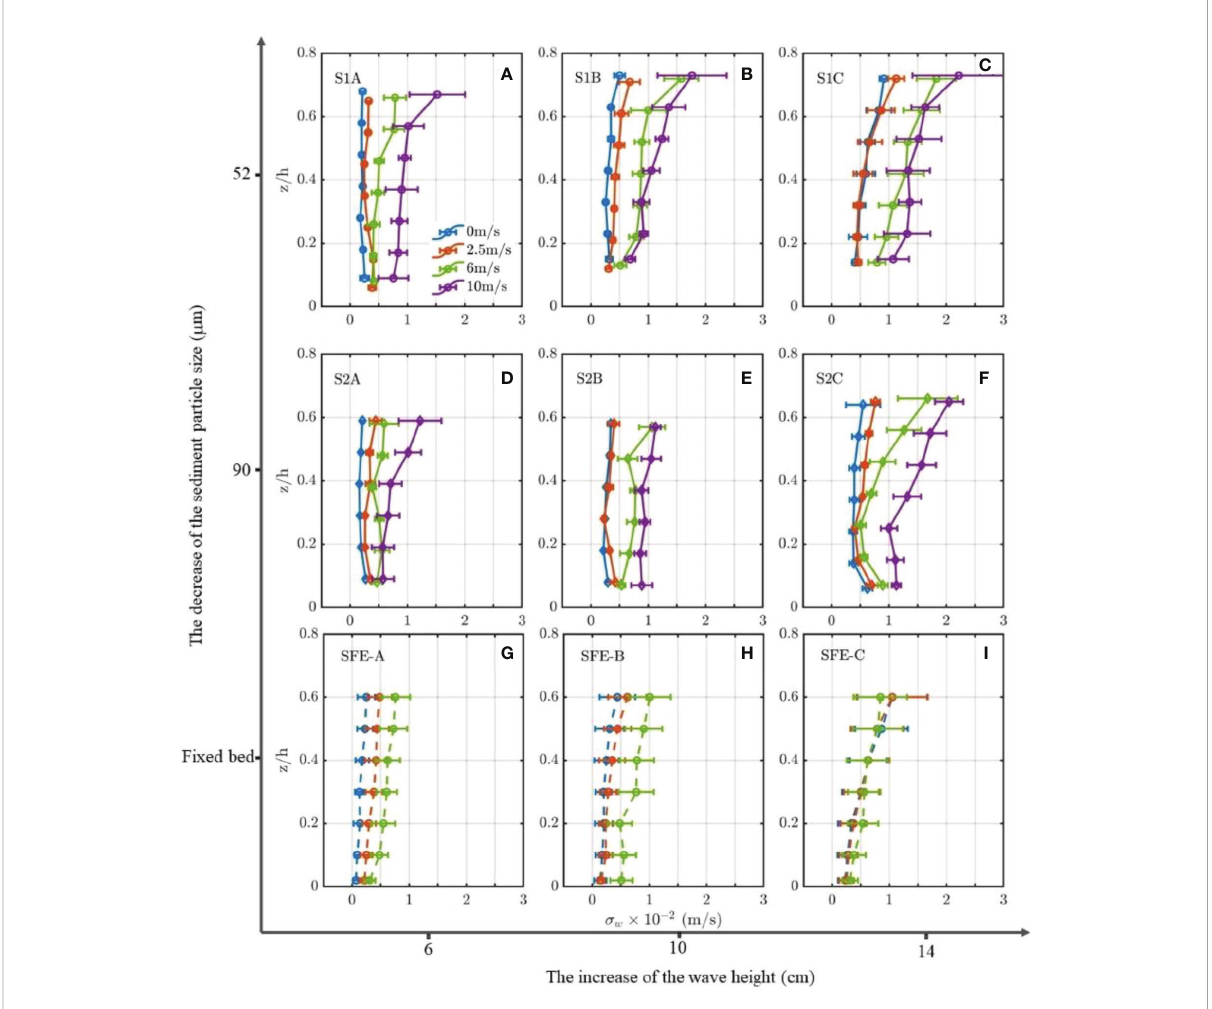
FIGURE 6 Time-averaged s w of S1 (A – C) , S2 (D, E) and 2017-SFE (G – I) . Lines of different colors represent waves combined with the wind of various strengths. The capital letters in the upper left of each graph represent the sediment type and the experimental case. Bars are ensemble standard